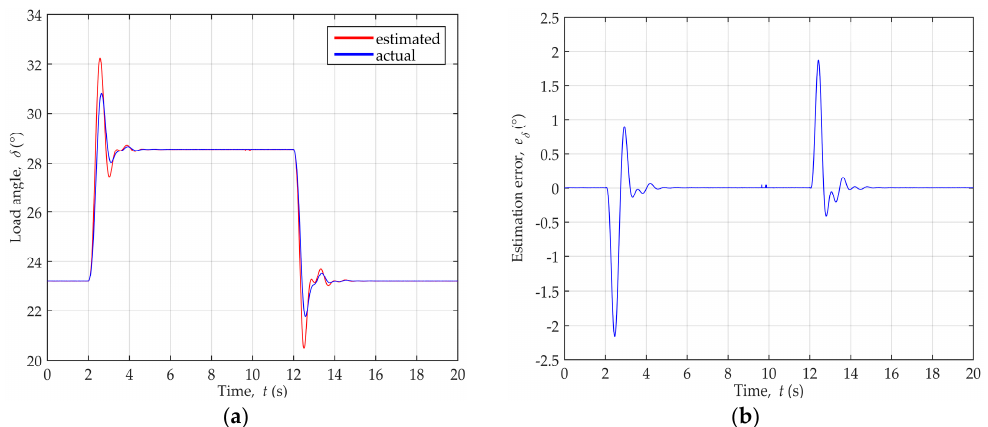
Figure 6. Load angle variation during dynamic disturbances of reactive power for generator operating